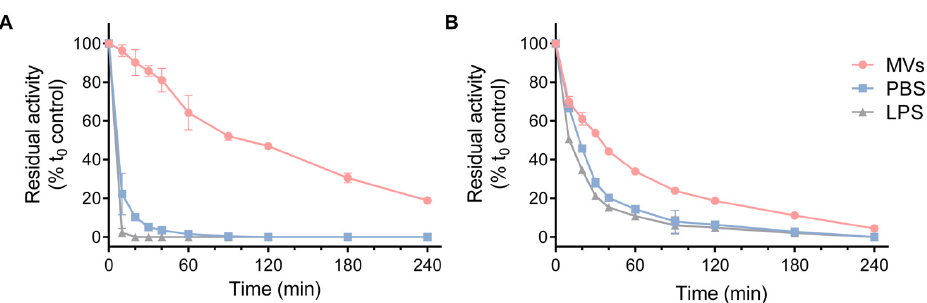
Figure 2. Stabilizing effect induced by the incubation of P. aeruginosa MVs with ( A ) HQD S . b . and ( B ) AqdC. The enzymes were incubated at 37 ◦ C with 0.2 mg/mL P. aeruginosa PA14 MVs (protein- based concentration), LPS (1 mg/mL in PBS) or PBS as a control. The residual enzymatic activity was determined at the specified time intervals. The data represent the mean ± SD of three